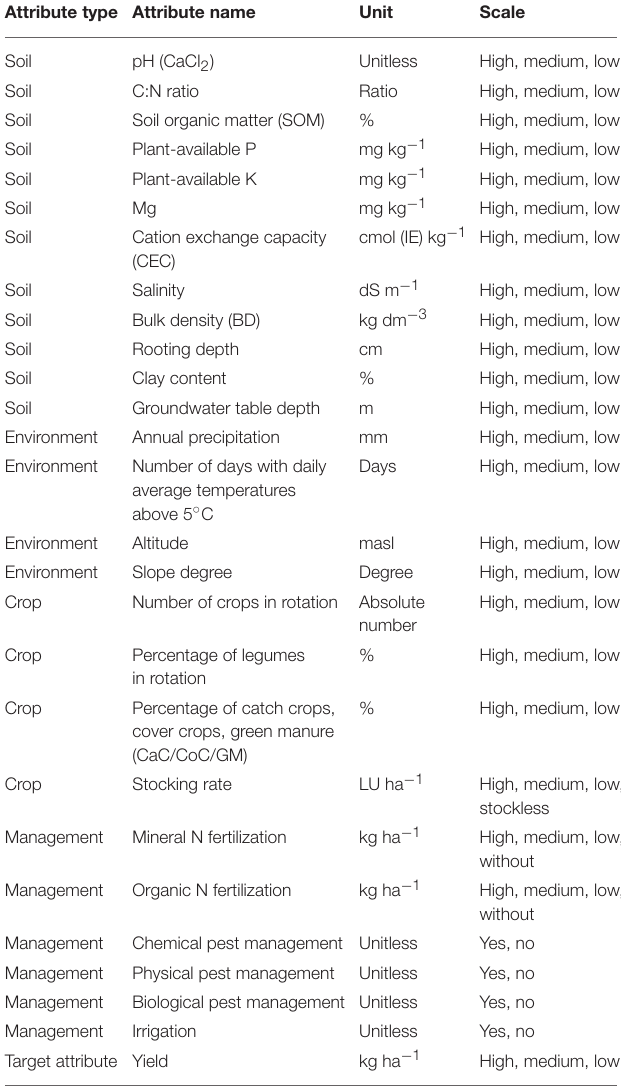
TABLE 1 | Primary productivity attributes that underwent discretization with corresponding units and scale